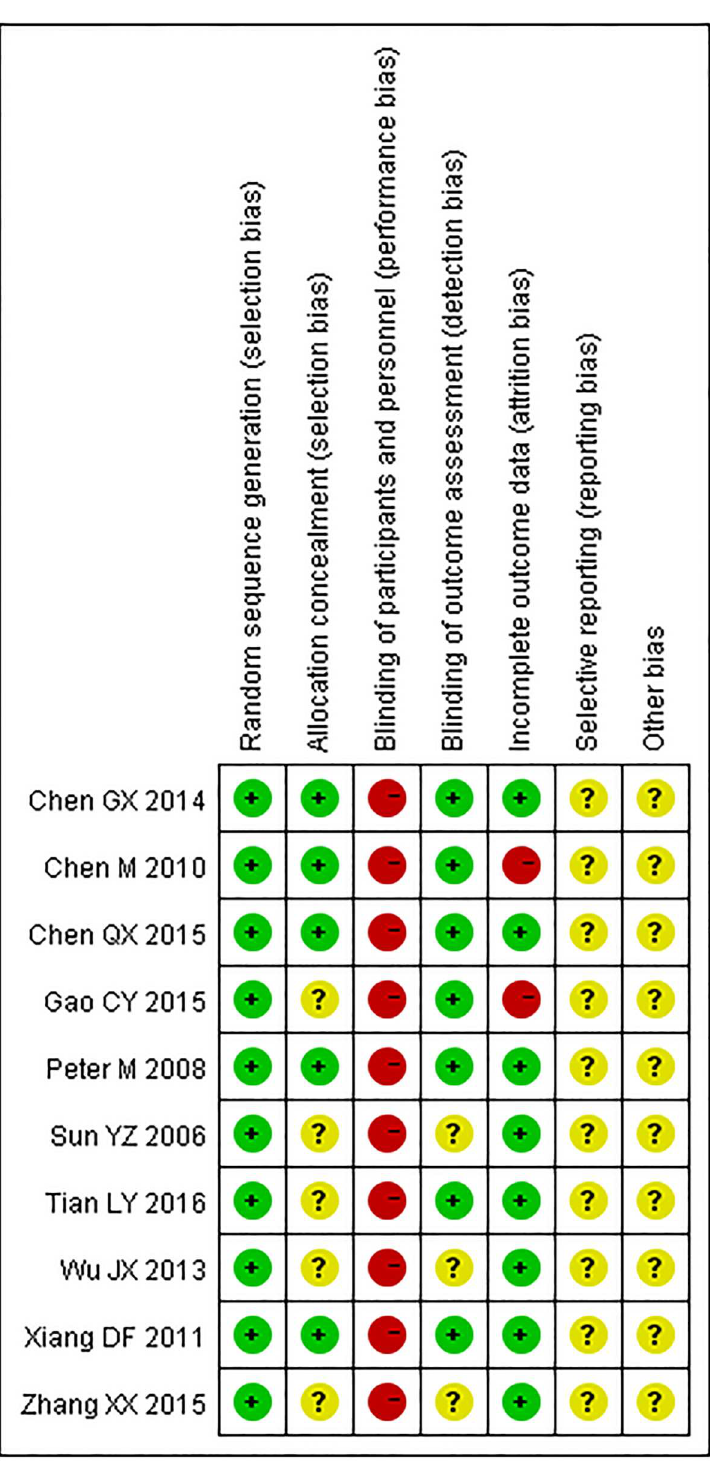
PLOS ONE | https://doi.org/10.1371/journal.pone.0186616 October 27,